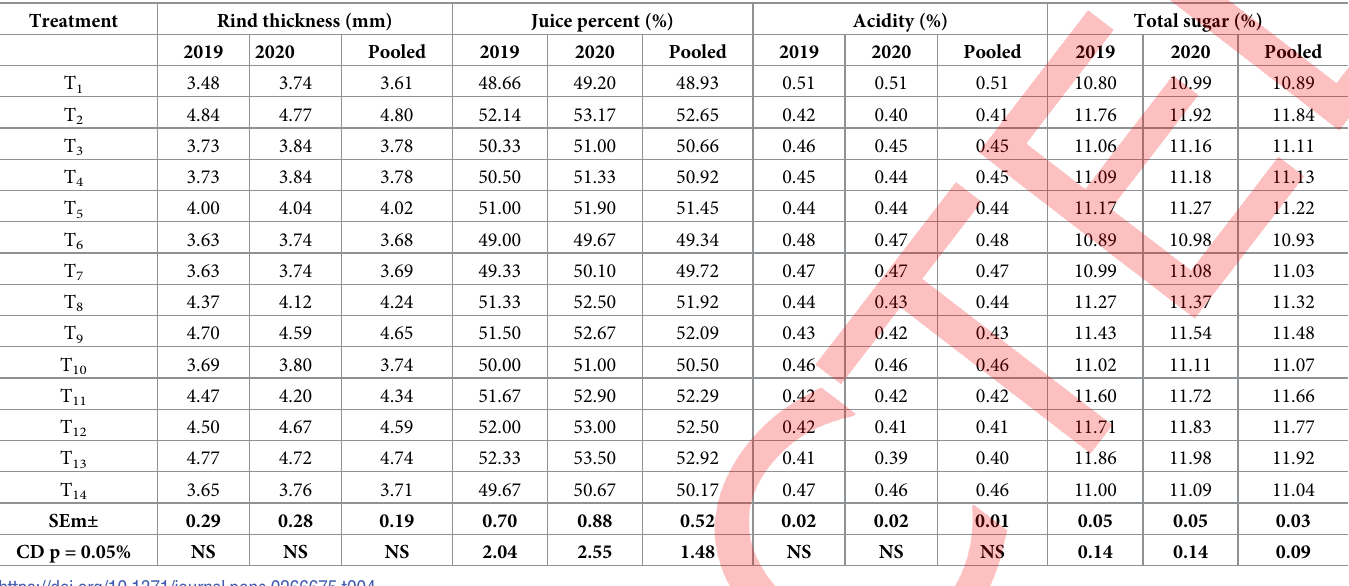
Table 4. Effect of organic manures on fruit quality characteristics of pomegranate cv. ‘Bhagwa’.